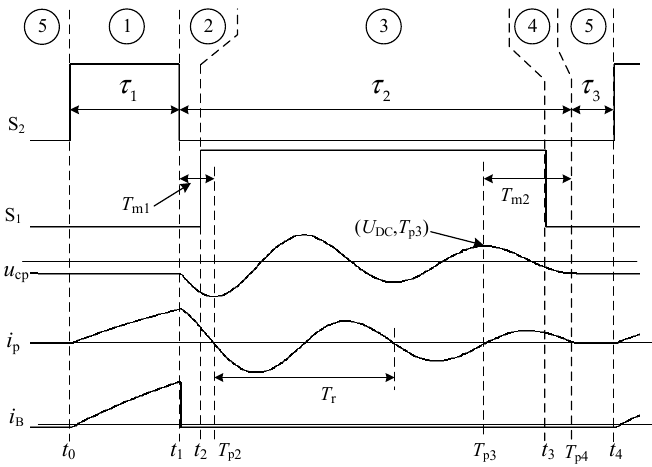
Figure 7. The waveforms of the bus current, primary current, and tank capacitor voltage of the IIEIFR converter.